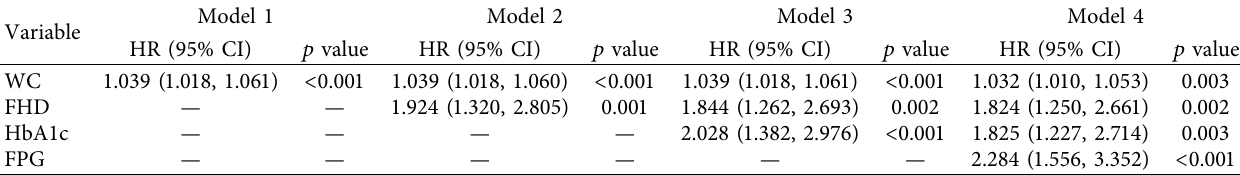
Table 2: Multivariable Cox proportional-hazards regression models for predicting